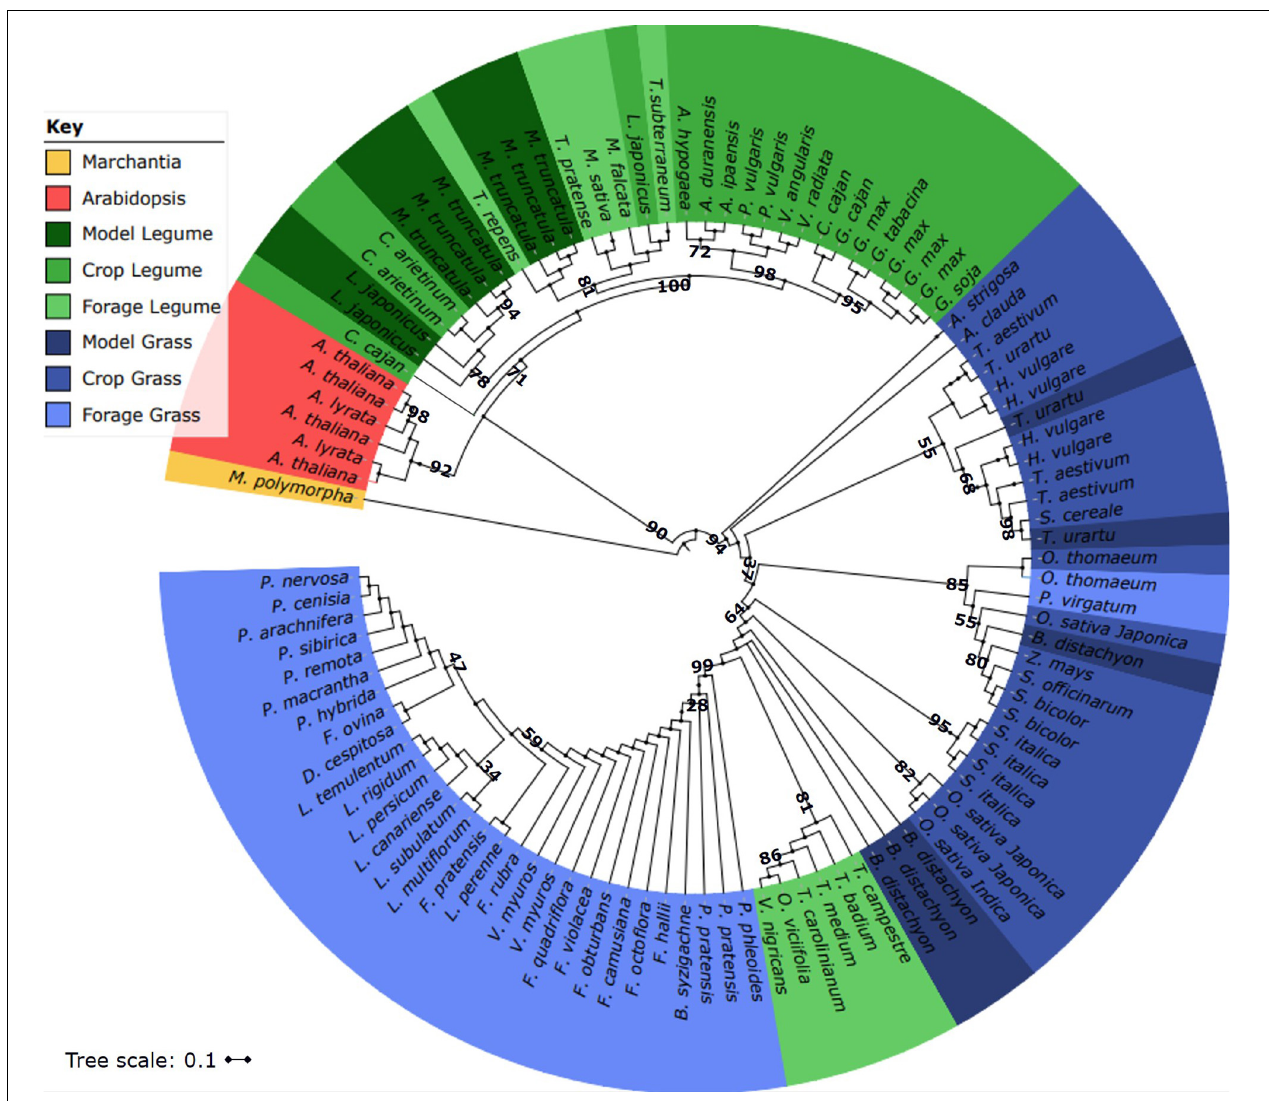
FIGURE 4 | Phylogeny of temperate legumes and grasses for Ribulose-1,5-bisphosphate carboxylase/oxygenase small subunit ( rbcS ), also including Arabidopsis thaliana and Marchantia polymorpha as outliers. Both known and predicted coding sequences for all species of interest were gathered from GenBank, PLAZA 3.0 Dicots and PLAZA 4.0 Monocots. Multiple sequence alignments (MSA) were performed using MAFFT v7 (Katoh and Standley, 2013) with a E-INS-I iterative refinement method and bootstrapping = 100. The phylogeny was built using Newick format in iTOL v3.4.3 (Letunic and Bork, 2007) and a radial phylogenetic tree produced. The tree was color coded to show model species, human food crops and forage crops for both legumes and grasses, although it should be noted that many can overlap in their